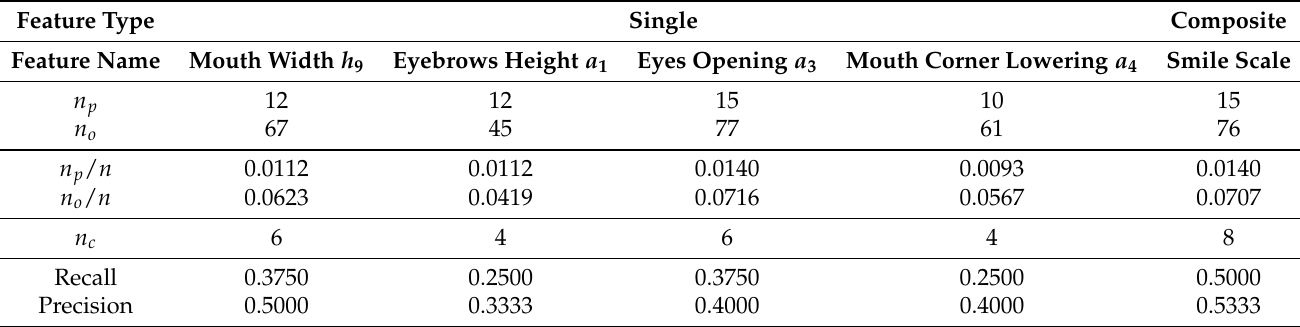
Table 5. Various parameters and ratios measured (Subject C: number of whole data n = 1075, number of event points n e = 16).